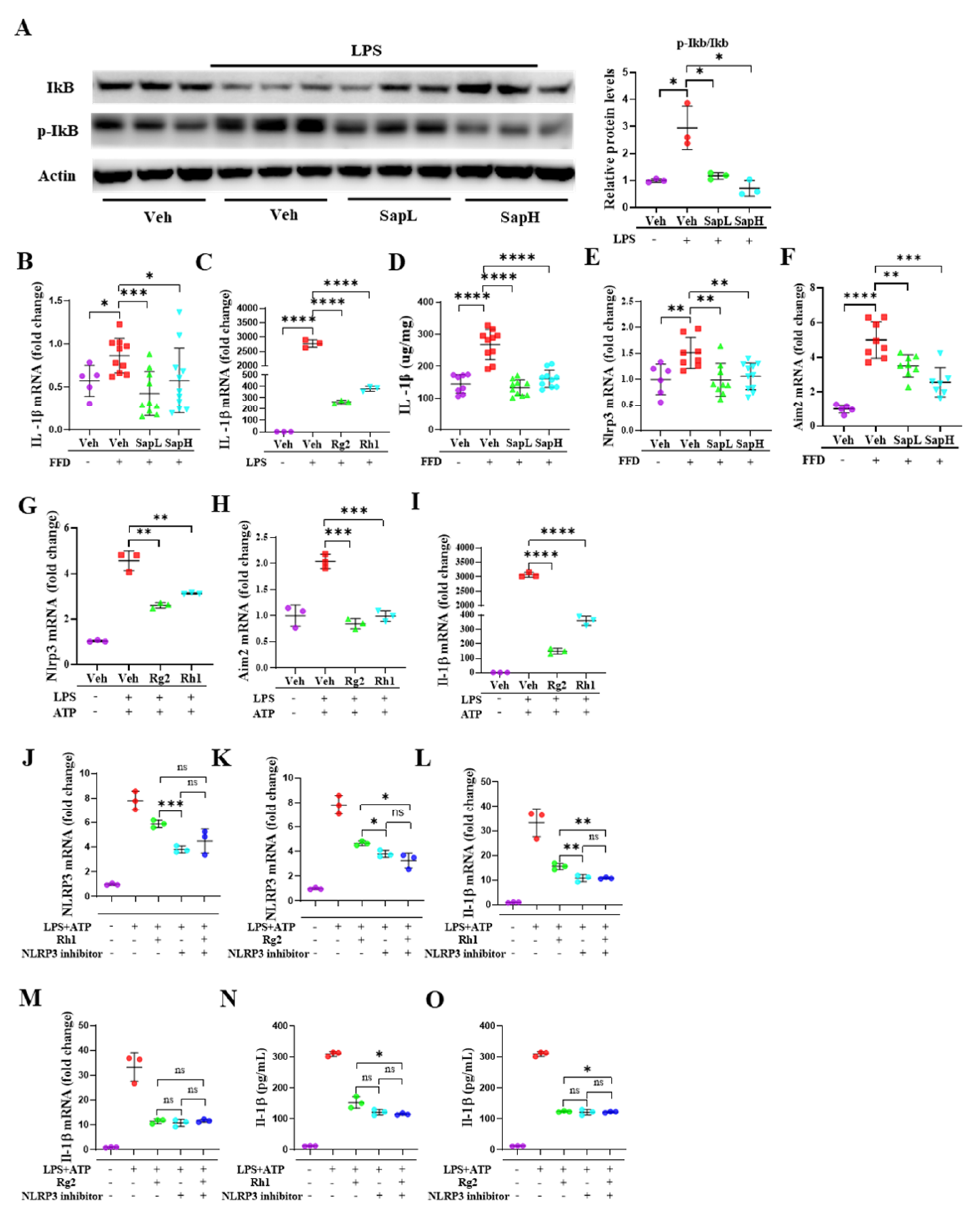
Figure 5. Ginsenoside Rh1 and Rg2 treatment inhibits the activation of the NLRP3 inflammasome. ( A ) Representative Western blotting analysis of IkB, p-IkB, and Actin. Saponin extract 62.5 µ g/mL is referred to as SapH and Saponin extract 31.25 µ g/mL as SapL. The mRNA expression of IL-1 β in ( B ) liver tissue and ( C ) in ImKCs. ( D ) The protein level of IL-1 β in liver tissue lysates was determined by ELISA. The mRNA expression of the NLRP3 inflammasome ( E ) and Aim2 inflammasome ( F ) in liver tissue and in ImKCs ( G , H ). The mRNA expression of IL-1 β ( I ) in ImKCs. The mRNA expression of NLRP3 inflammasome treated with ginsenoside Rh1 ( J ) and Rg2 ( K) in ImKCs. The mRNA expression of IL-1 β treated with ginsenoside Rh1 ( L ) and Rg2 ( M ) in ImKCs. The protein level of IL-1 β treated with ginsenoside Rh1 ( N ) and Rg2 ( O ) in the cell culture was determined by ELISA. Relative mRNA expression levels were normalized to mouse GAPDH levels. The data are expressed as means ± sem. * p < 0.05, ** p < 0.01, *** p < 0.001, and **** p <